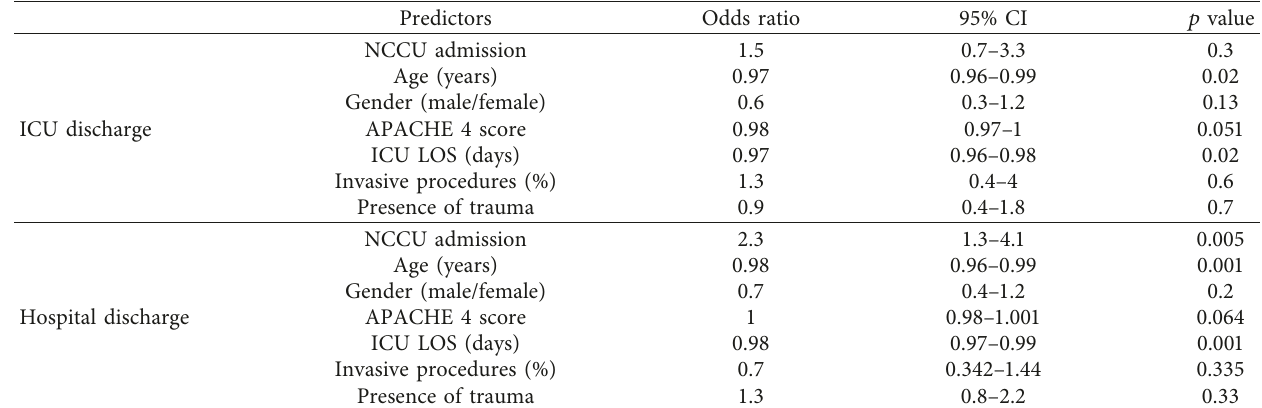
Table 3: Predictors for ICU/hospital discharge.